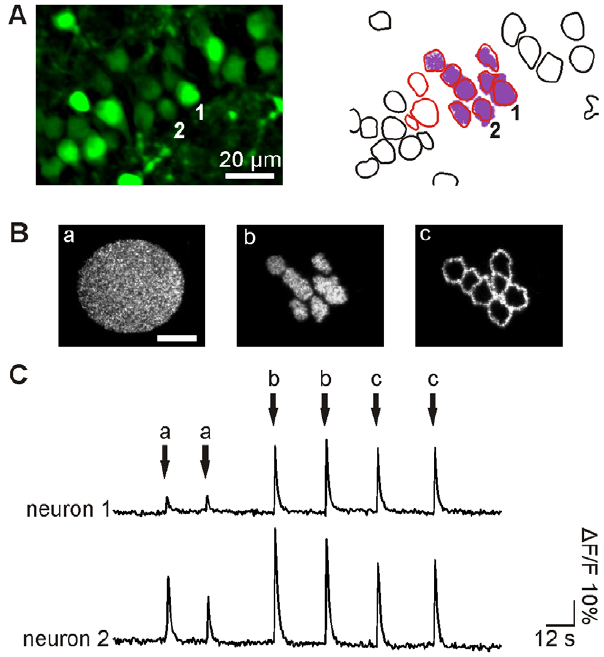
Figure 5. Ca 2 + imaging upon holographic photostimulation of multiple neurons. A . (left) Fluorescence images obtained with HiLo microscopy showing CA1 neurons of a hippocampal slice. (right) Scheme of responding (red) and non-responding (black) cells to photostimulation with a shaped pattern (blue). B . Images of the three patterns used to photostimulate target neurons in CA1 with MNI- glutamate using the same energy of 3.6 m J, corresponding to 1.7 nJ/ m m 2 , 6.2 nJ/ m m 2 and 18.1 nJ/ m m 2 for the elliptic, shaped and anti- shaped patterns, respectively. C . Variation of intracellular Ca 2 + concentration of two different target neurons during photostimulation with the three different pattern configurations. than with shaped patterns (those membranes being located up and below the focal plane).